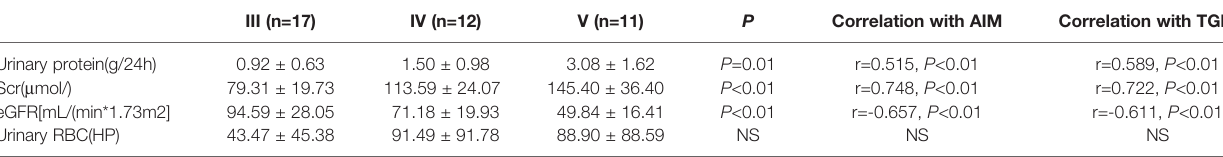
TABLE 1 | Correlation between clinical characteristics and AIM, TGF- b 1 of IgAN patients with different pathological stage. III (n=17) IV (n=12) V (n=11)